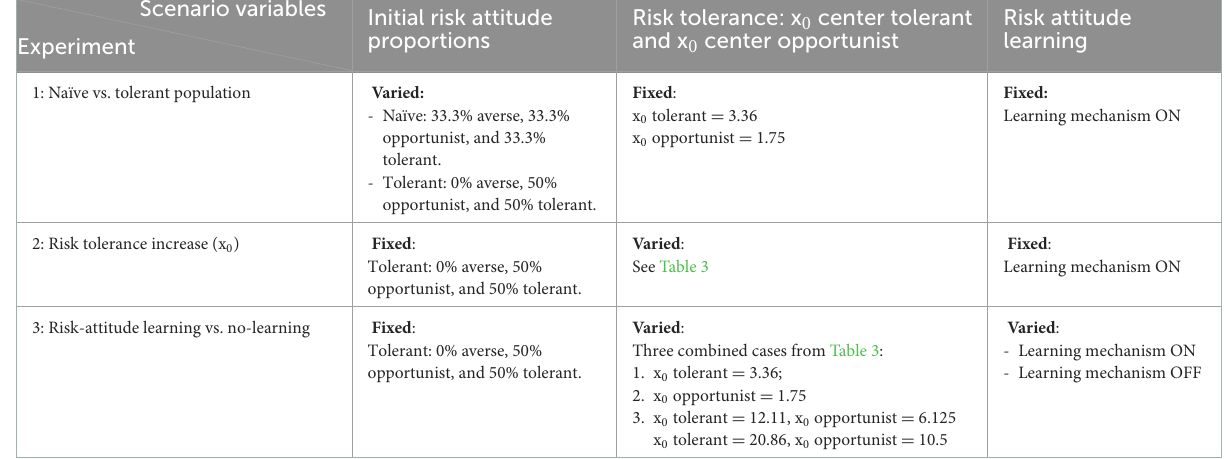
TABLE 1 Variables used to test model sensitivity. Parameter